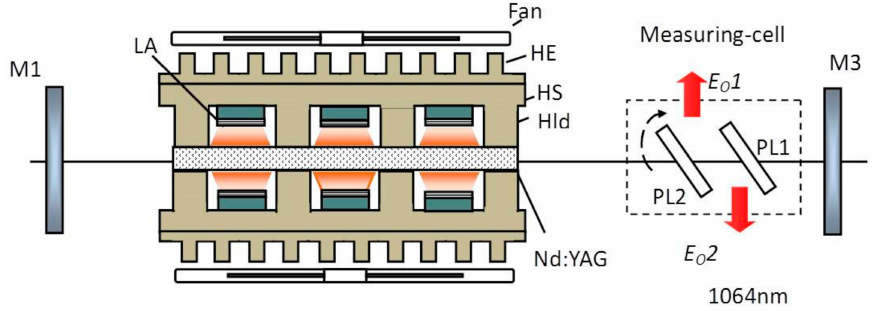
Figure 5. Schematic of the experimental setup for the comparison and the optimization.